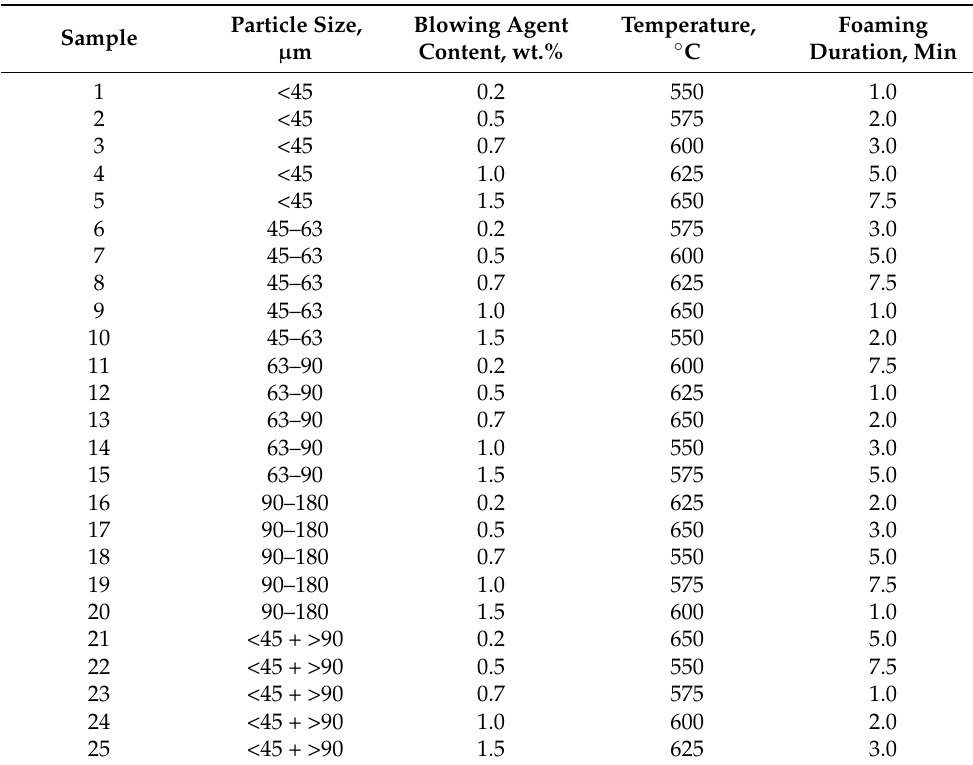
Table 2. DoE for the foaming